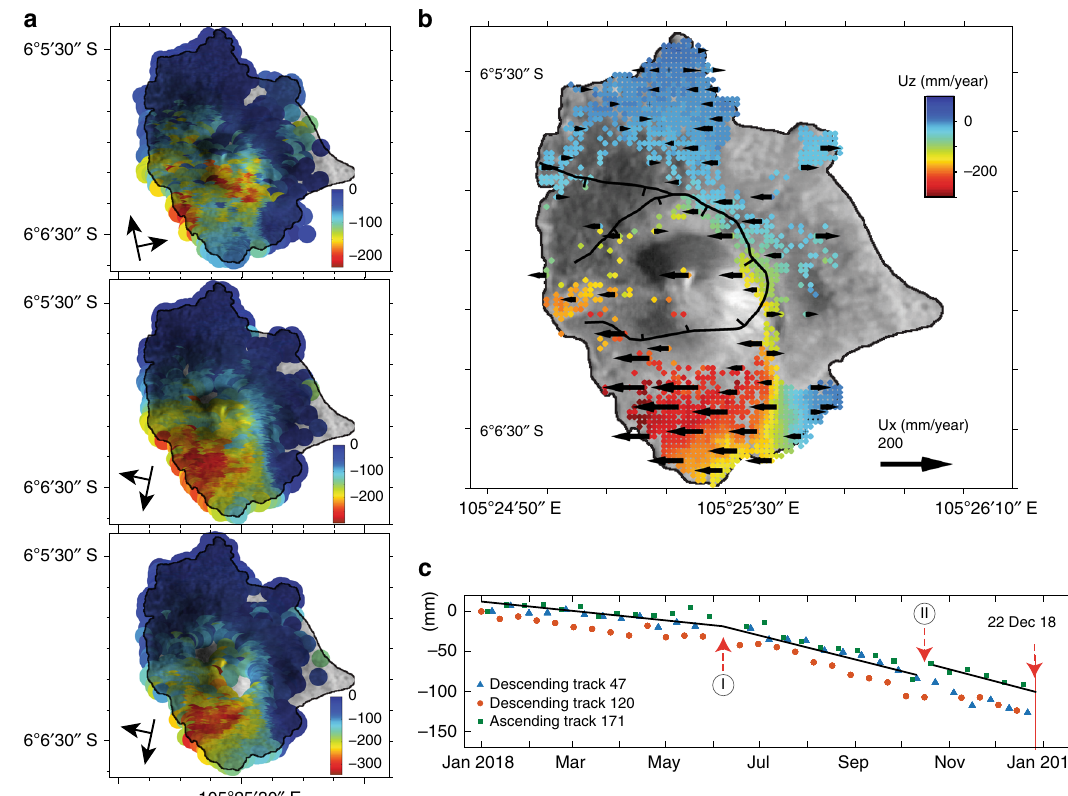
Fig. 3 Deformation maps and island perimeter changes. a InSAR time series showing the movement of the ground in the satellites ’ line-of-sight (LOS) direction, generated for the period between 1 January and 22 December 2018 for one ascending and two descending tracks. The different viewing geometries reveal the deformation of the southwestern fl ank of Anak Krakatau. b Average vertical (colors, red is down) and E-W (black vector symbols) movement computed from the different InSAR viewing geometries. c Deformation trends for the different tracks (average pixel values in the inner sector collapse scarp outline) showing pronounced trend changes in June – September 2018, labeled I and II, and identifying the 22 December 2018 collapse event. Maps created using the GMT/MATLAB Toolbox